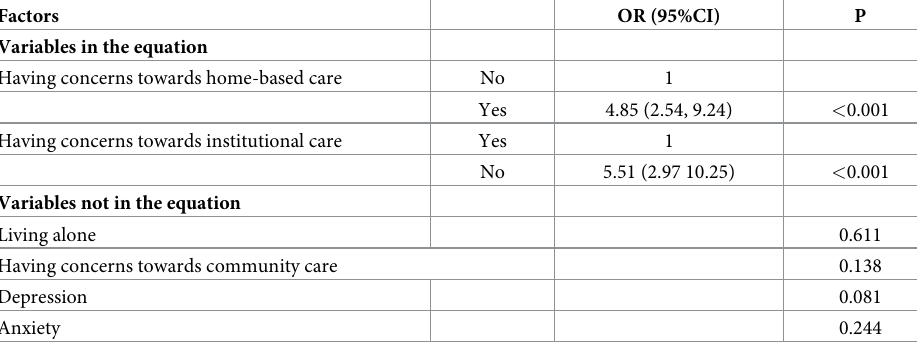
Table 5. Factors associated with willingness to receive institutional